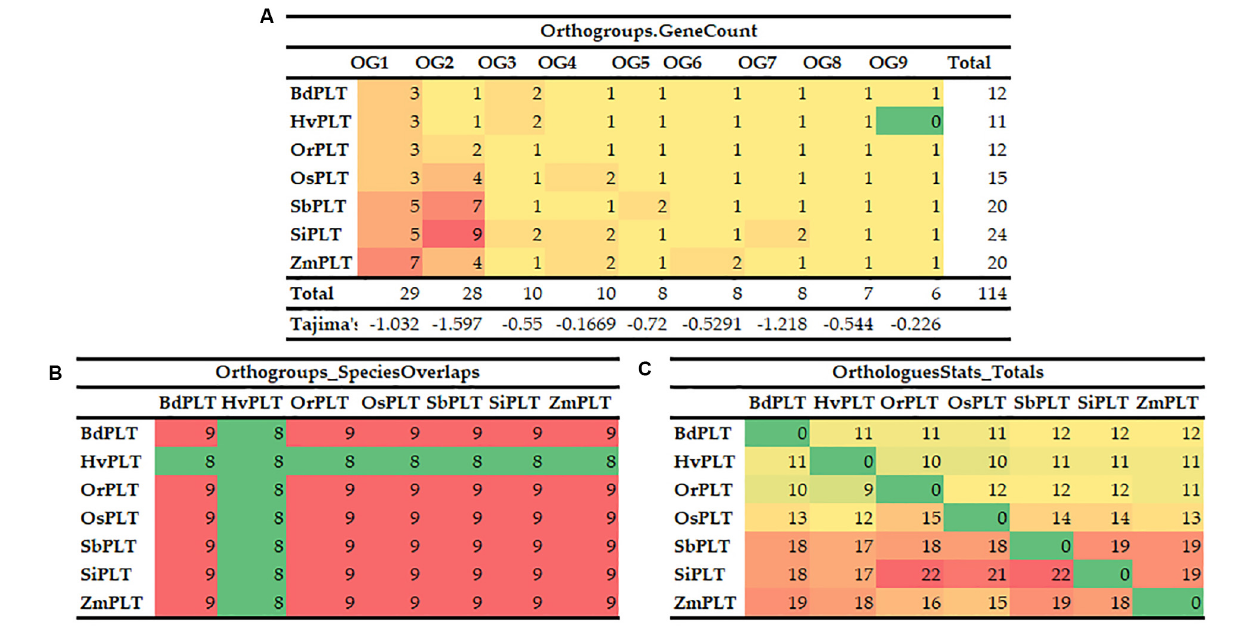
(Kalyaanamoorthy et al.,